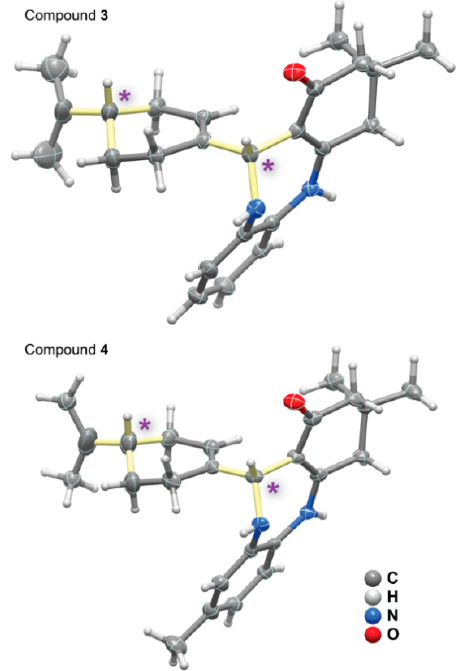
Figure 4. Schematic representation of the ( S , S )-diastereomers molecular units present in the crystal structures of compounds 3 and 4 (note: the ( S , R )-diastereomer molecules present in the asymmetric units were omitted for clarity). Asymmetric carbon centres are depicted by an asterisk and the bonds are in light yellow. Non-hydrogen atoms are represented as thermal ellipsoids drawn at the 50% probability level and hydrogen atoms as small spheres with arbitrary radii.